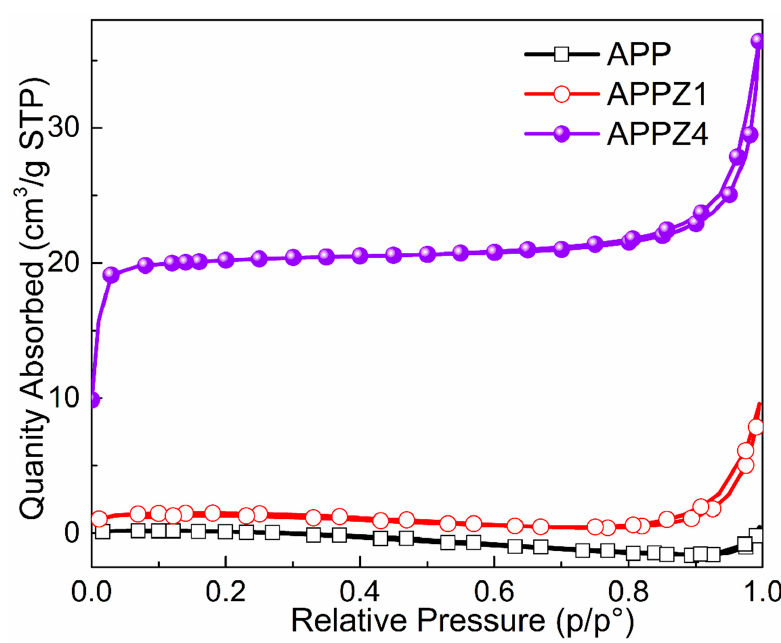
Figure 4. N 2 -sorption isotherms for APP-ZIF particles.